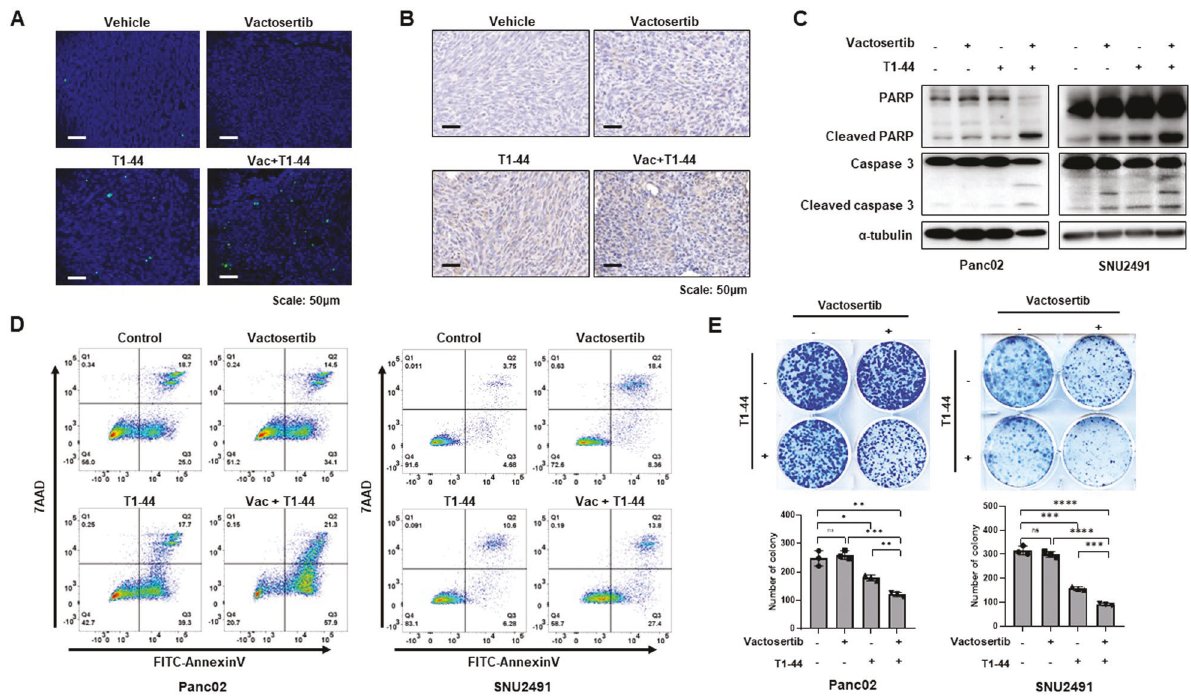
Fig. 4 Positive regulation of apoptotic process by co-treatment of Vactosertib and T1-44. A TUNEL assay of primary tumor tissues from Panc02 mouse experiment. Green fl uorescence dots indicate apoptotic positive cells. B Immunohistochemistry staining of cleaved-caspase3 C . Western blotting data of PARP and Caspase3. Cleaved forms of two protein indicate apoptosis signaling. D Flow cytometry of Annexin V-7AAD staining. E Colony forming assay of Panc02 and SNU2491 cell lines under treatment of Vactosertib and